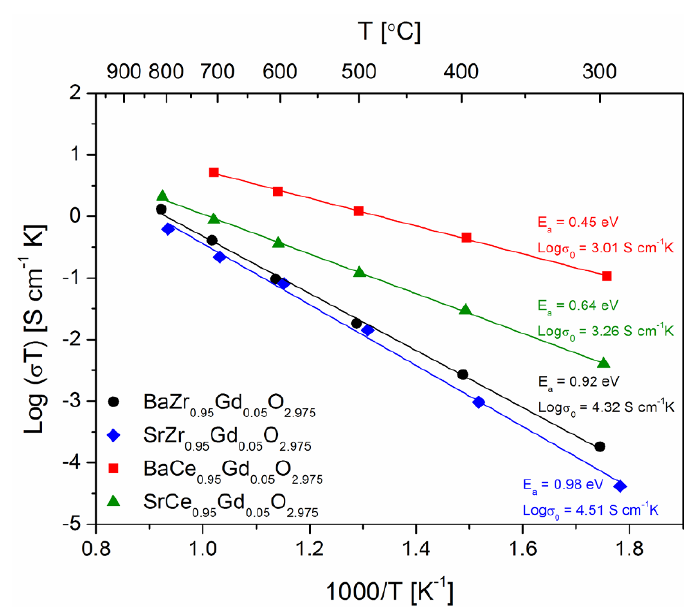
Gd O at 300°C in humidified 0.95 0.05 2.975